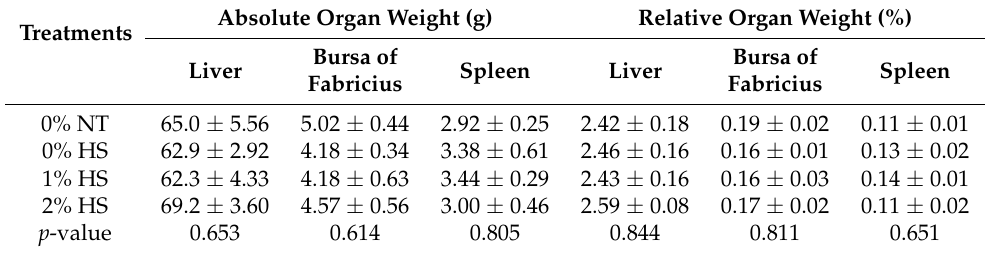
Table 3. Effects of dietary steam-exploded pine particles supplementation on the absolute organ weight (g) and relative organ weight (% body weight) of thermoneutral and heat-stressed broiler chickens.